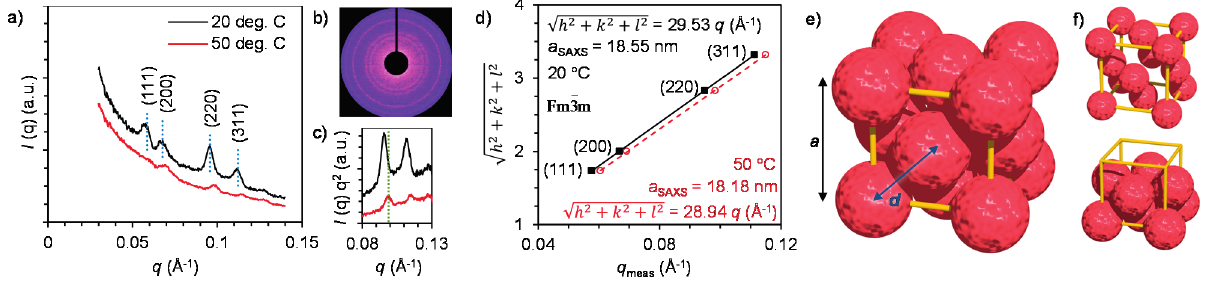
Figure 3. ( a ) Azimuthally integrated SAXS profiles for aFT- 4 complexes measured at 20 and 50 °C. Dotted vertical lines indicate the calculated peak positions for a fcc structure with a = 18.55 nm; ( b ) 2D scattering profile of the 20 °C sample; ( c ) Comparison between the (220) and (311) peak positions measured at different temperatures highlights the change in lattice constant; ( d ) Quadratic Miller indices of assigned reflections for fcc structure versus measured q -vector positions for indexed peaks. Lines present linear fits, which yield lattice parameters 18.55 and 18.18 nm at 20 and 50 °C, respectively; ( e ) Face-centered cubic (fcc) unit cell (yellow) of aFT particles (red) drawn to scale; and ( f ) unit cell with aFT diameter reduced for clarity (top) and unit cell with top 5 aFT